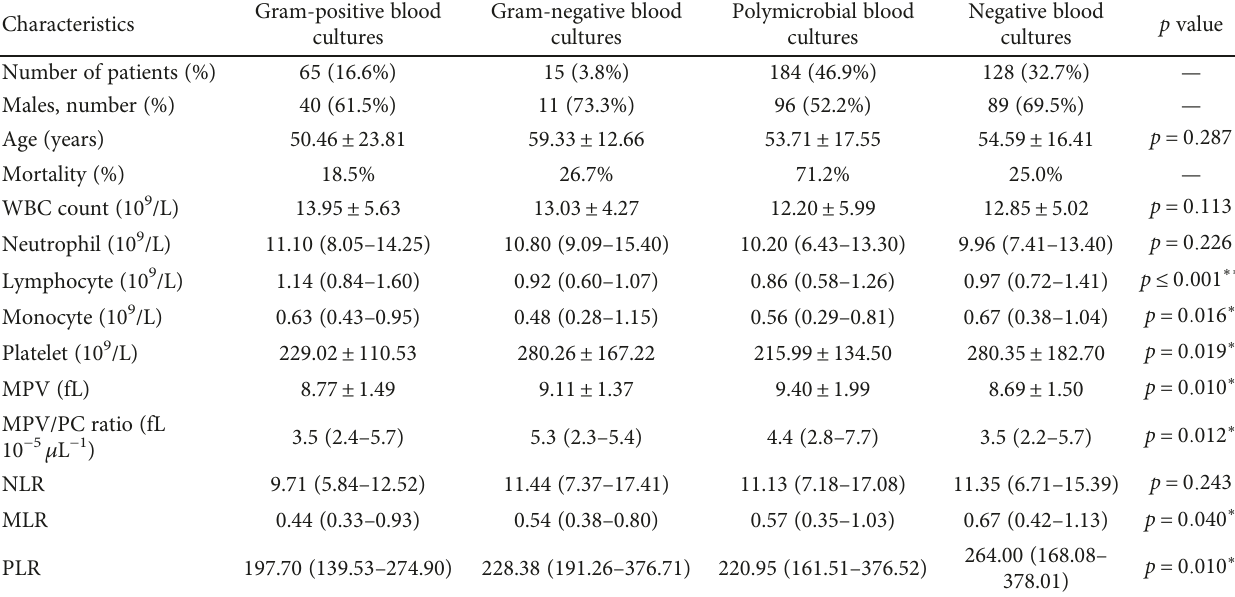
Table 3: Baseline and laboratory characteristics of all patients according to blood cultures.